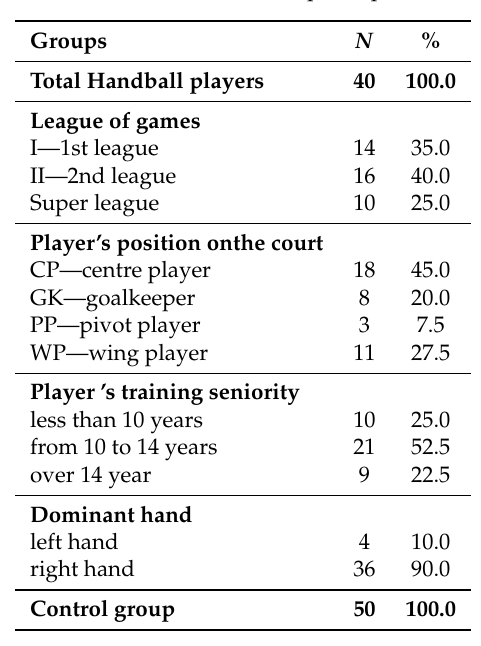
Table 1. Characetristic of